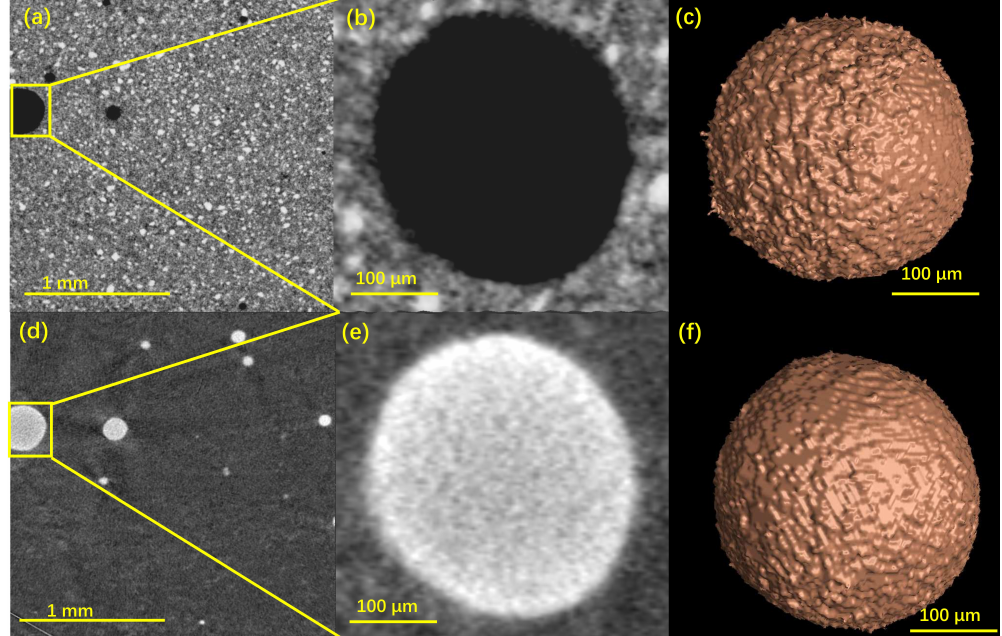
Figure 8. Representative images of a VOI in the cement sample ( a – c ) before and ( d – f ) after mercury intrusion: ( a , d ) the 2D sectional view with ( b , e ) the magnified pore and ( c , f ) its 3D structure.